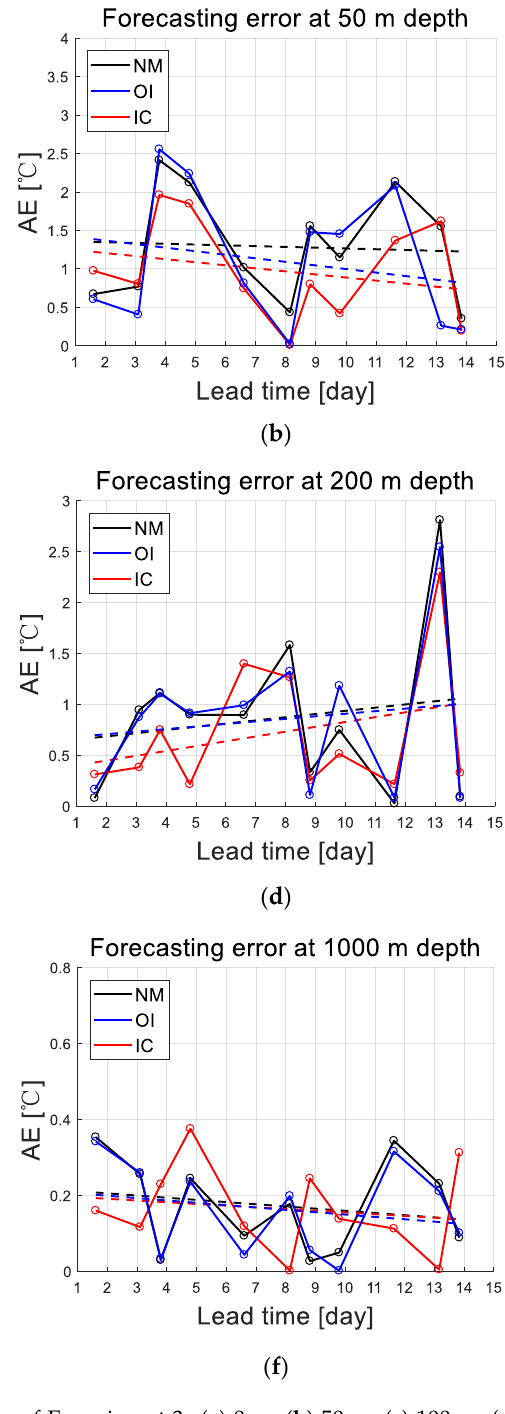
Figure 7. Temperature forecasting error of Experiment 3. ( a ) 0 m; ( b ) 50 m; ( c ) 100 m; ( d ) 200 m; ( e ) 500 m; ( f ) 1000 m. The black line is the forecasting error of the original numerical model (NM), the blue line is the forecasting error of the OI, the red line is the forecasting error of the IC and the dashed line is the error regression line. Figure 8 is the temperature forecasting error of Experiment 4. The results of Experi- ment 4 show that at the surface and at the depths of 50 and 500 m, the correcting effect of the OI and the IC is not obvious. At the depths of 100 and 200 m, the overall forecasting